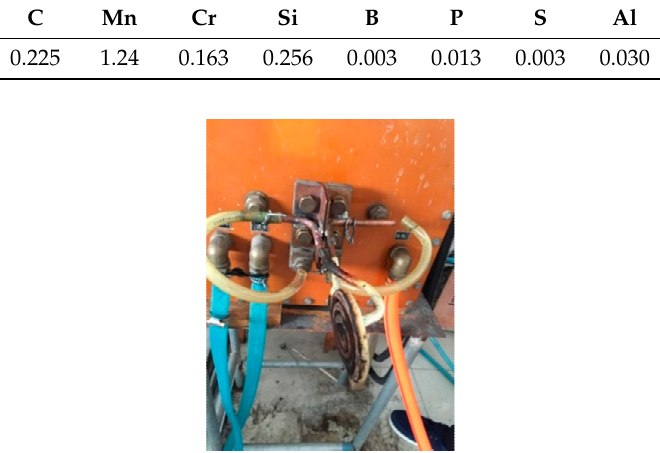
Figure 2. Induction heating experimental device.